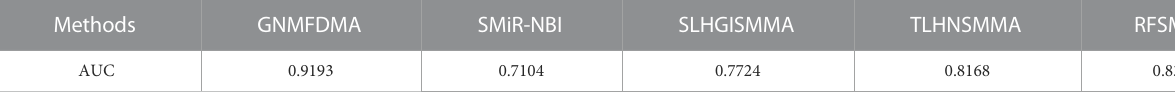
TABLE 2 The AUC values of GNMFDMA and four compared methods in 5-CV. Methods